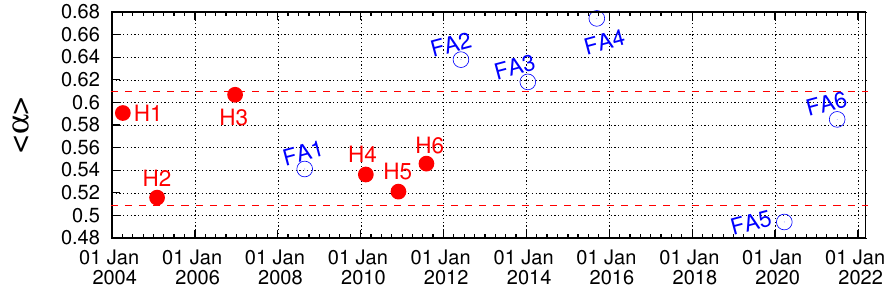
Figure 9. Values of (cid:104) α (cid:105) for each of the ‘precursory’ fluctuation minima on the date of β 160, min of Table 1. The labels indicate whether they correspond to hit (H1 to H6, red bullets) or a false alarm (FA1 to FA6, blue circles). The dashed horizontal dashed red lines indicate the limits of Condition (14), i.e., 0.51 and 0.61, which when applied, validates all hits, while only FA1 and FA6 remain as false